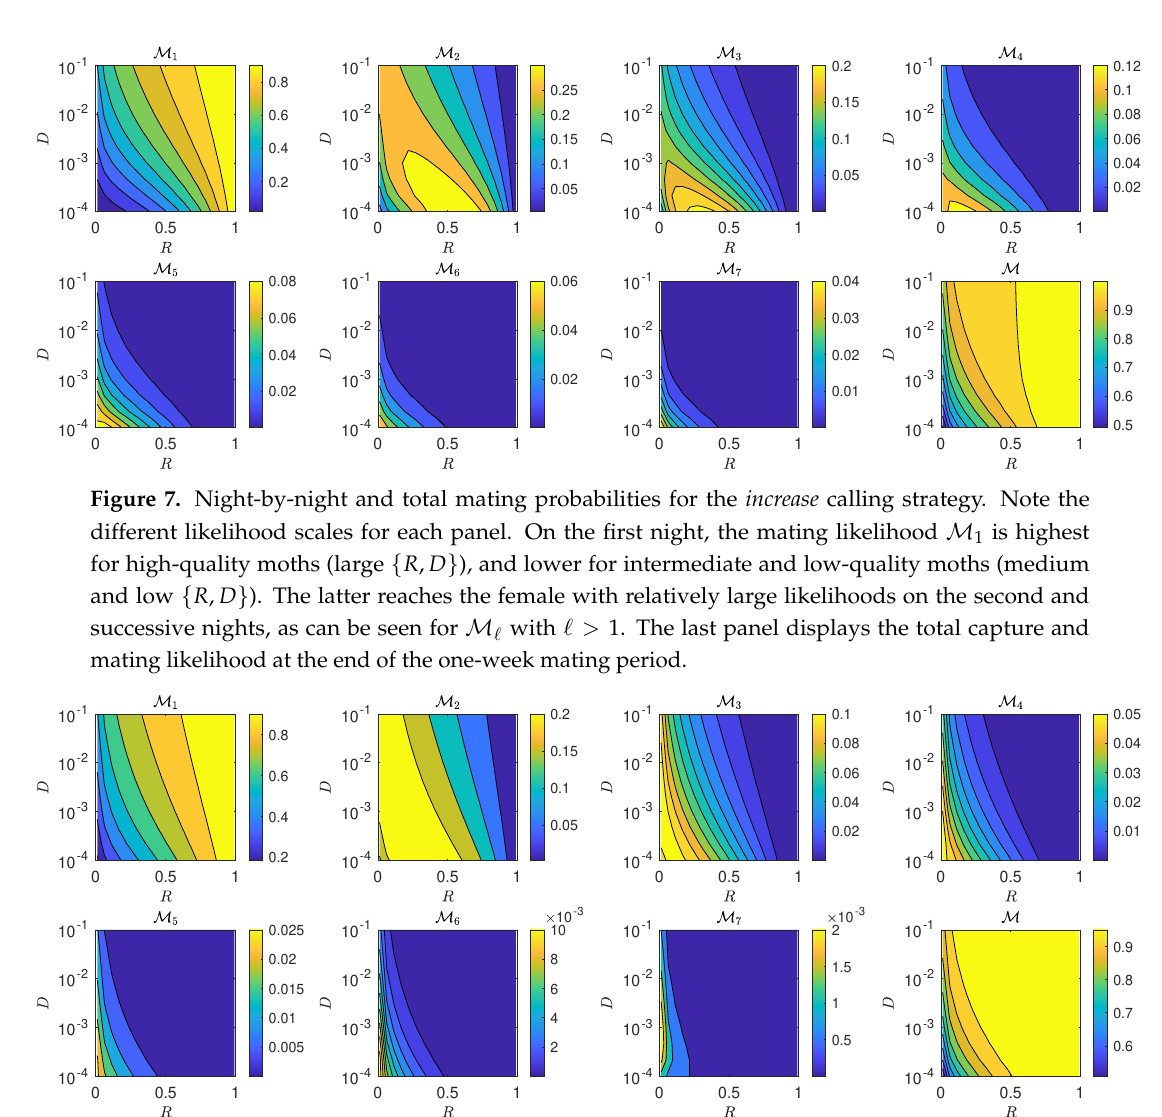
Figure 8. Night-by-night and total mating probabilities under decrease calling. Note the different likelihood scales for each panel. Similar to Figure7, intermediate-quality moths (medium { R , D } ) display relatively large mating likelihoods M (cid:96) on the second and successive